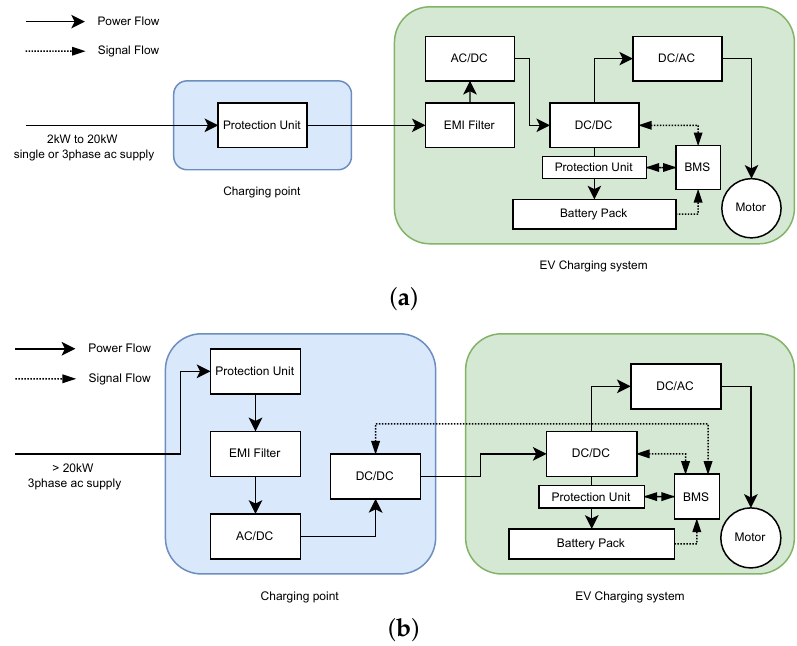
Figure 3. EV charging system topologies: ( a ) onboard charging, ( b ) offboard charging. Based on the different battery charger typology adopted (level 1, level 2, or